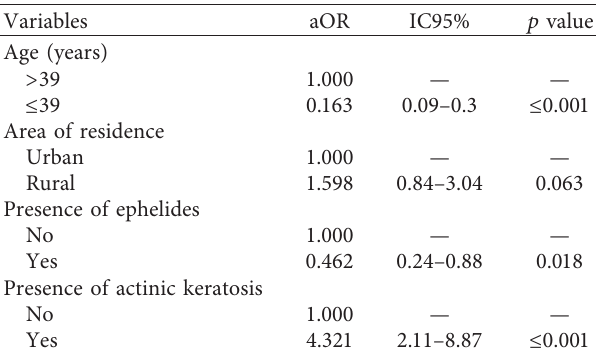
Table 3: Risk factors associated with skin cancer in PWA (mul- tivariate analysis).